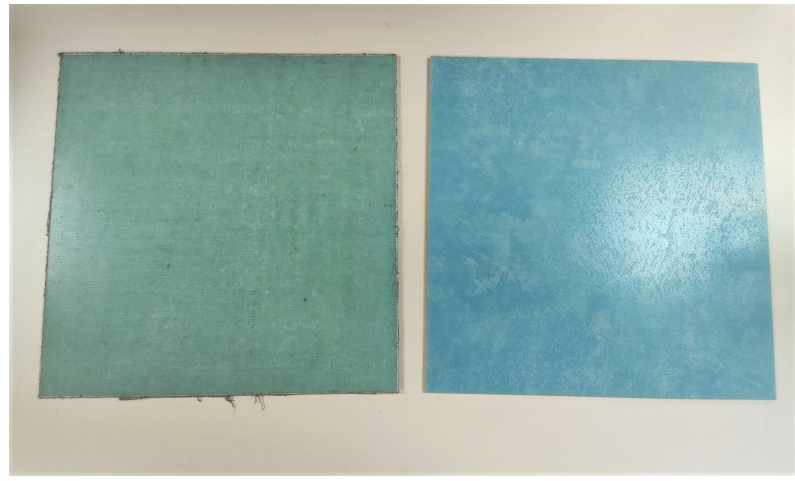
Figure 5. Composite materials of polyethylene fiber ( left ) and quartz ( right ). The stacking sequence of each of the samples and their properties is found in Table 2. Table 2. Prepeg of quartz and polyethylene fibers, laminates properties. Stacking Material Number of Plies Resin Permittivity Theoric Sequence